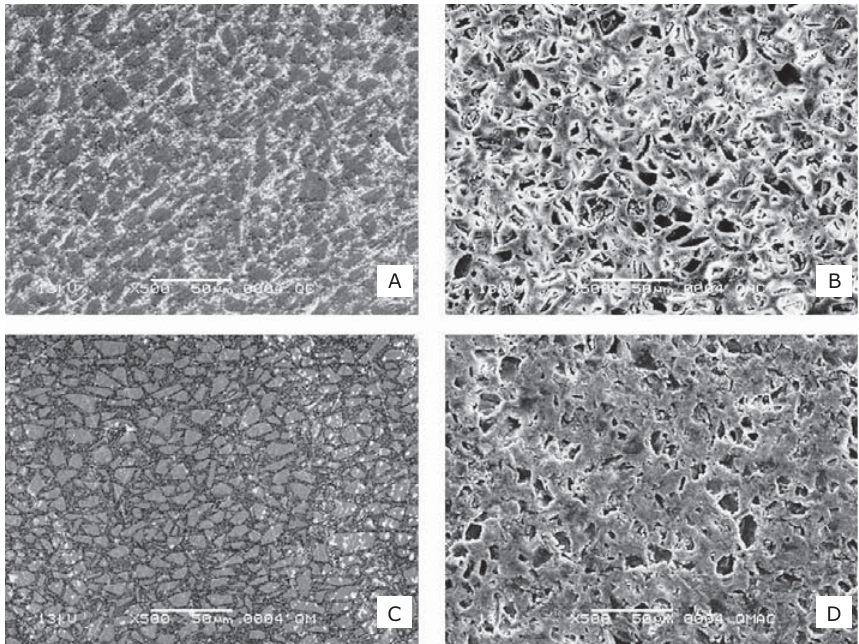
Figure 3- (cid:8)"(cid:26)(cid:21)(cid:12)%(cid:11)(cid:14)(cid:8)(cid:20)(cid:12)(cid:8)(cid:13)(cid:26)(cid:11)(cid:8)(cid:24)(cid:20)(cid:18)(cid:15)(cid:26)(cid:20)(cid:7)(cid:20)%(cid:16)(cid:8)(cid:20)?(cid:8)(cid:2)(cid:3)(cid:4)(cid:5)(cid:6)(cid:7)(cid:8)(cid:11)\(cid:21)(cid:7)(cid:3)(cid:21)(cid:13)(cid:11)(cid:25)(cid:8)!(cid:16)(cid:8)(cid:14)(cid:27)(cid:21)(cid:12)(cid:12)(cid:4)(cid:12)%(cid:8)(cid:11)(cid:7)(cid:11)(cid:27)(cid:13)(cid:18)(cid:20)(cid:12)(cid:8)(cid:24)(cid:4)(cid:27)(cid:18)(cid:20)(cid:14)(cid:27)(cid:20)(cid:15)(cid:16)](cid:8)"(cid:20)(cid:12)(cid:13)(cid:18)(cid:20)(cid:7)(cid:8)Q)^_(cid:8)‘(cid:24)(cid:24)(cid:11)(cid:18)(cid:14)(cid:4)(cid:20)(cid:12)(cid:8)(cid:4)(cid:12)(cid:8)(cid:27)(cid:4)(cid:13)(cid:18)(cid:4)(cid:27)(cid:8) acid (B); Toothbrush abrasion (C); Toothbrush abrasion after immersion in citric acid (D)